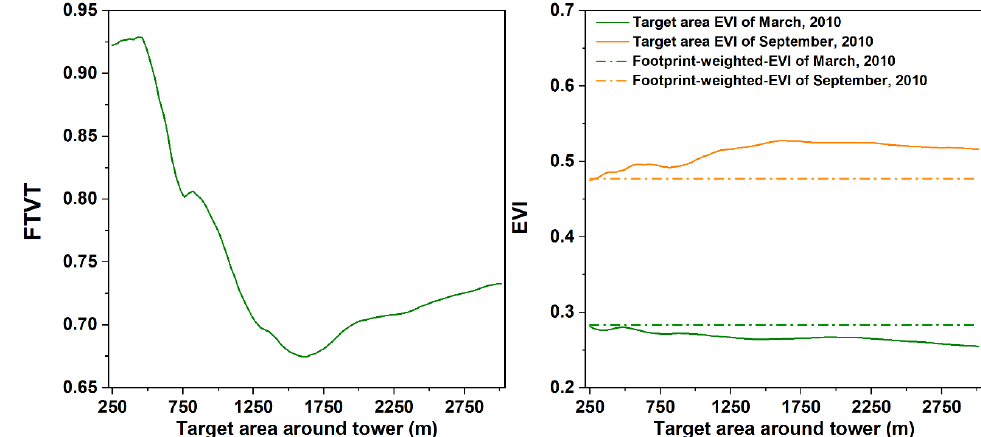
Figure 5. Changes of FTVT and EVI in a circular window with an increasing size from 300 to 3000 m. For the whole study period from 2003 to 2010, the distribution of the FTVT varied greatly along the wind direction. The FTVT was 0.89 when the wind direction was south-southwest but reduced to 0.65 when the wind direction changed to northeast due to the larger fraction of double-cropped rice in the east part of the flux site (Figure 6).